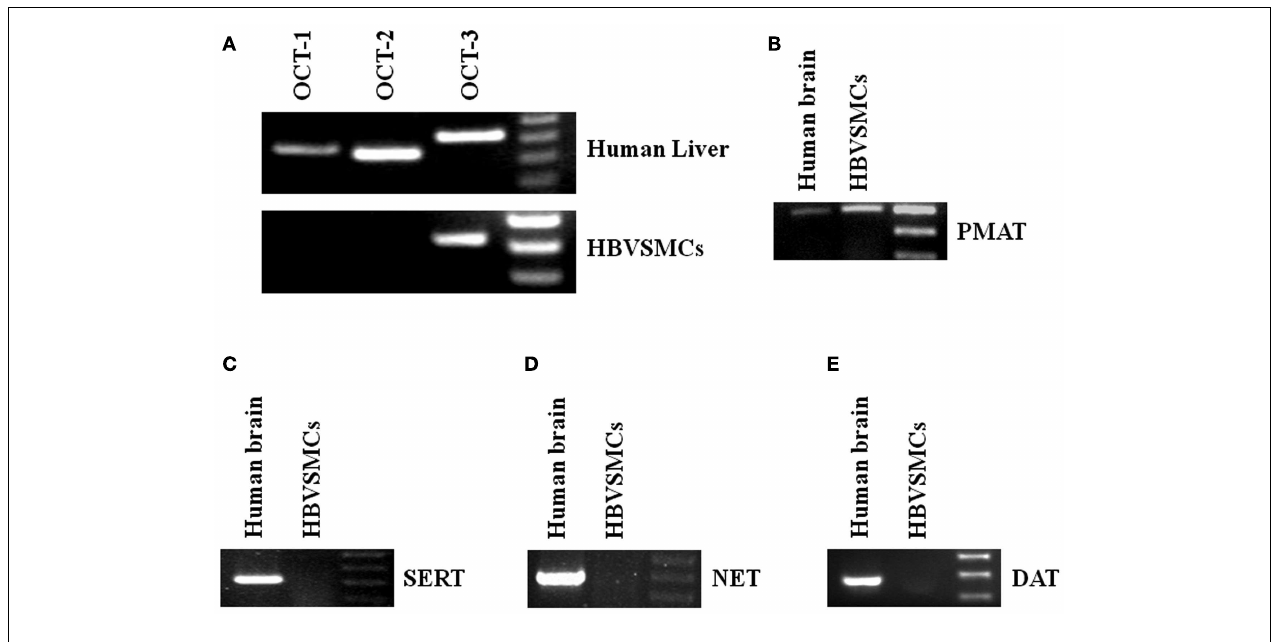
NET, and (E) DAT. Positive controls with human liver or brain cDNA indicate the expected sizes of amplified fragments: 363bp (OCT-1),